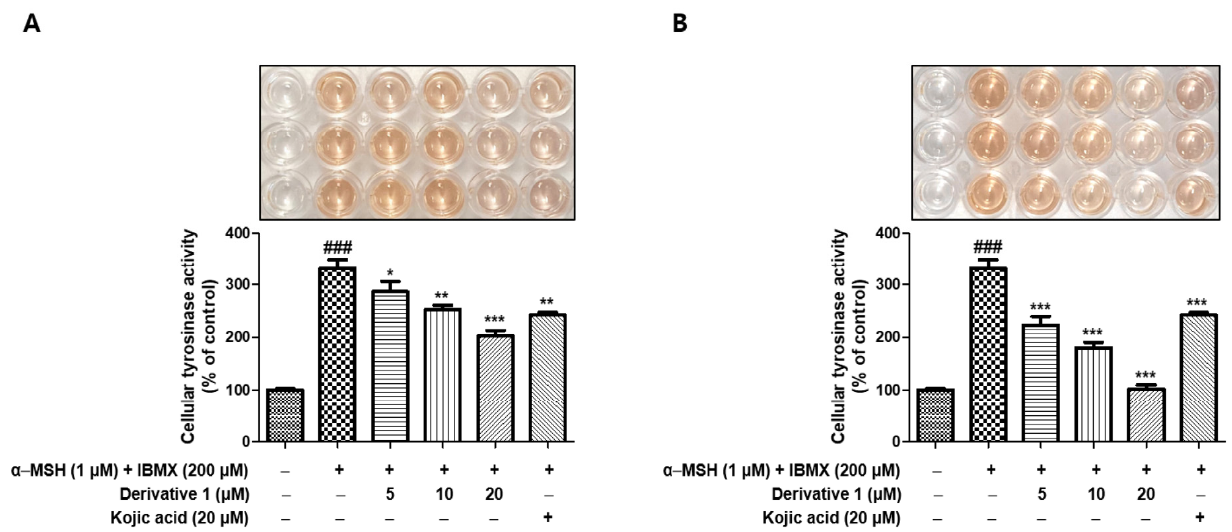
Figure 8. Anti-tyrosinase activities of ( Z )-BPT derivatives 1 and 2 in B16F10 cells. B16F10 cells were stimulated with 200 µ M of IBMX and 1 µ M of α -MSH in the presence of kojic acid (20 µ M, positive control) or ( Z )-BPT derivatives 1 and 2 (concentrations: 0, 5, 10, and 20 µ M) and incubated for 72 h. ( A ) Derivative 1 and ( B ) derivative 2 . Data are presented as the mean ± standard error of the mean. ### p < 0.001; * p < 0.05, ** p < 0.01, and *** p < 0.001.